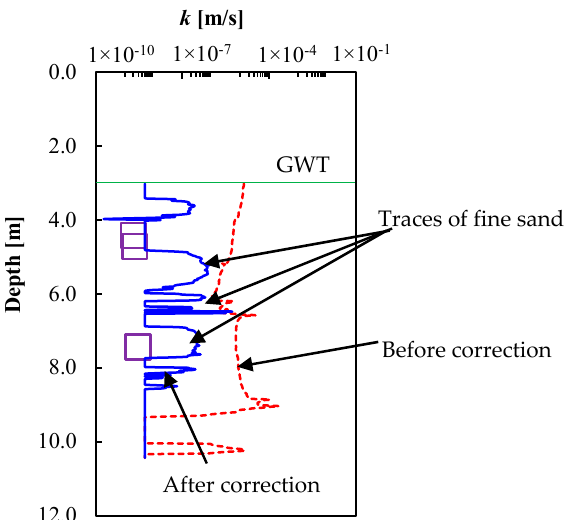
Figure 7. Measured and estimated hydraulic conductivity profile for Lincoln, NE, USA site.